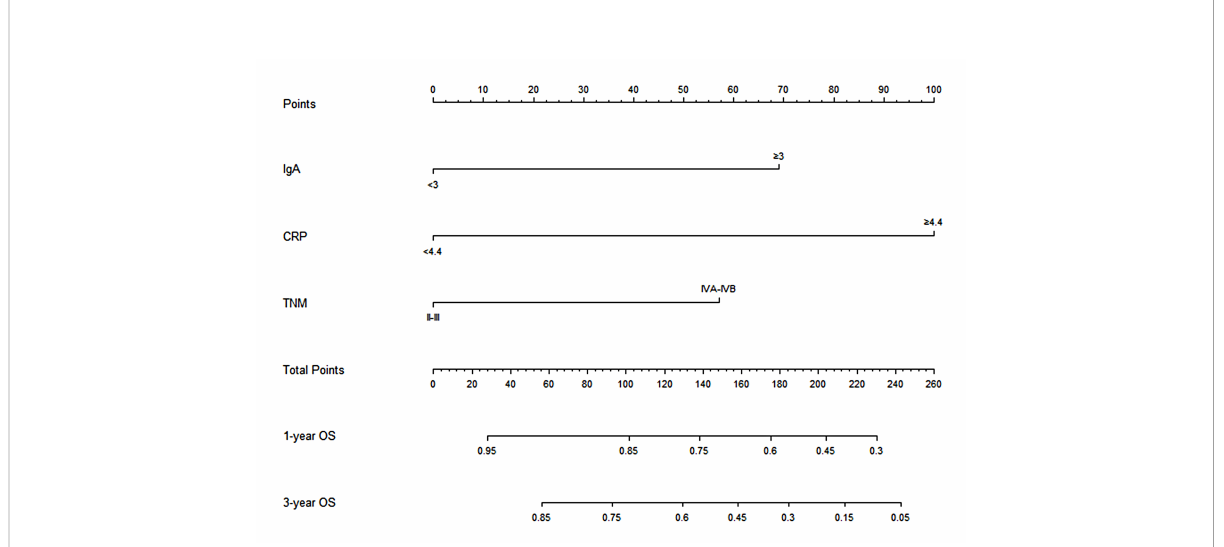
FIGURE 2 Nomogram based on CRP, IgA, and clinical TNM stage for predicting the 1- and 3-year OS in ESCC patients who received nCRT plus surgery, by summing up the points identi fi ed on the points scale for each variable. The total points projected on the bottom scales determined the probability of 1- and 3-year survival. CRP, C-reactive protein; IgA, immune globin A; OS, overall survival; ESCC, esophageal squamous cell carcinoma; nCRT, neoadjuvant